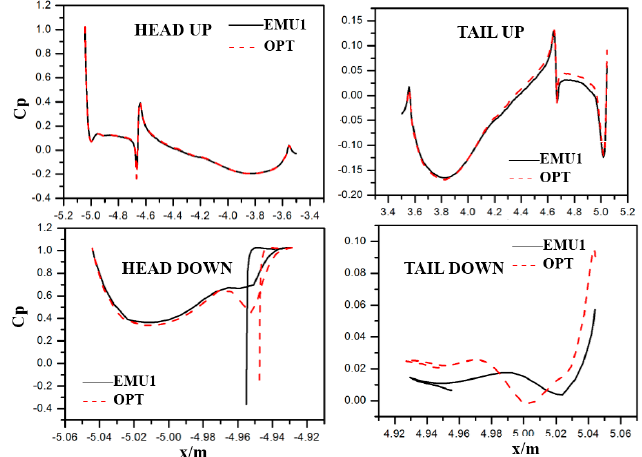
Figure 17. Pressure coefficient along the longitudinal profile of the leading car and trailing car before and after optimization.